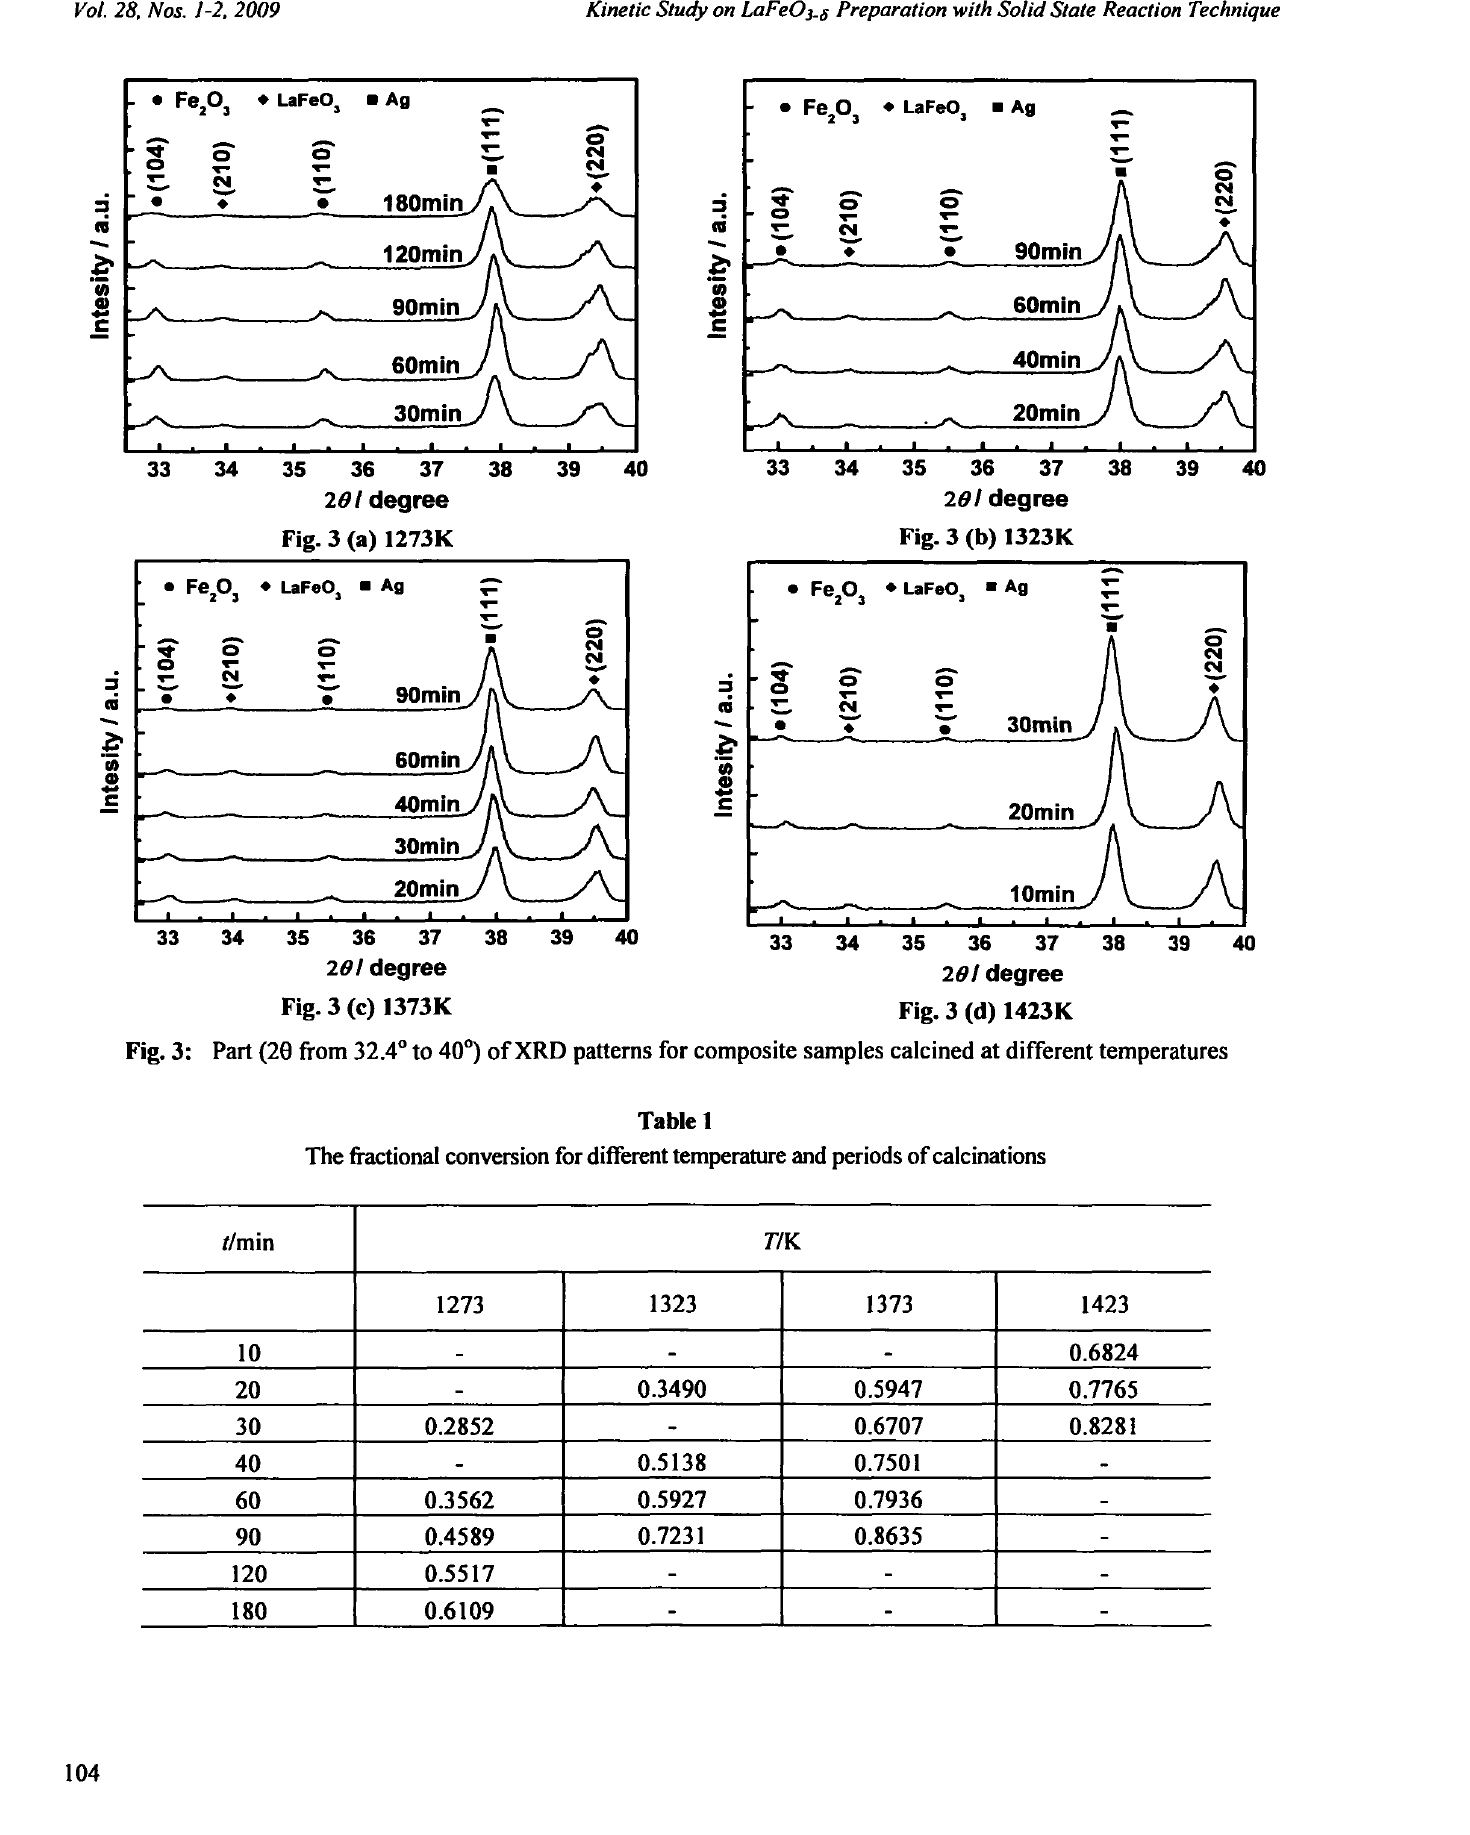
Fig. 3: Part (2Θ from 32.4° to 40°) of XRD patterns for composite samples calcined at different temperatures